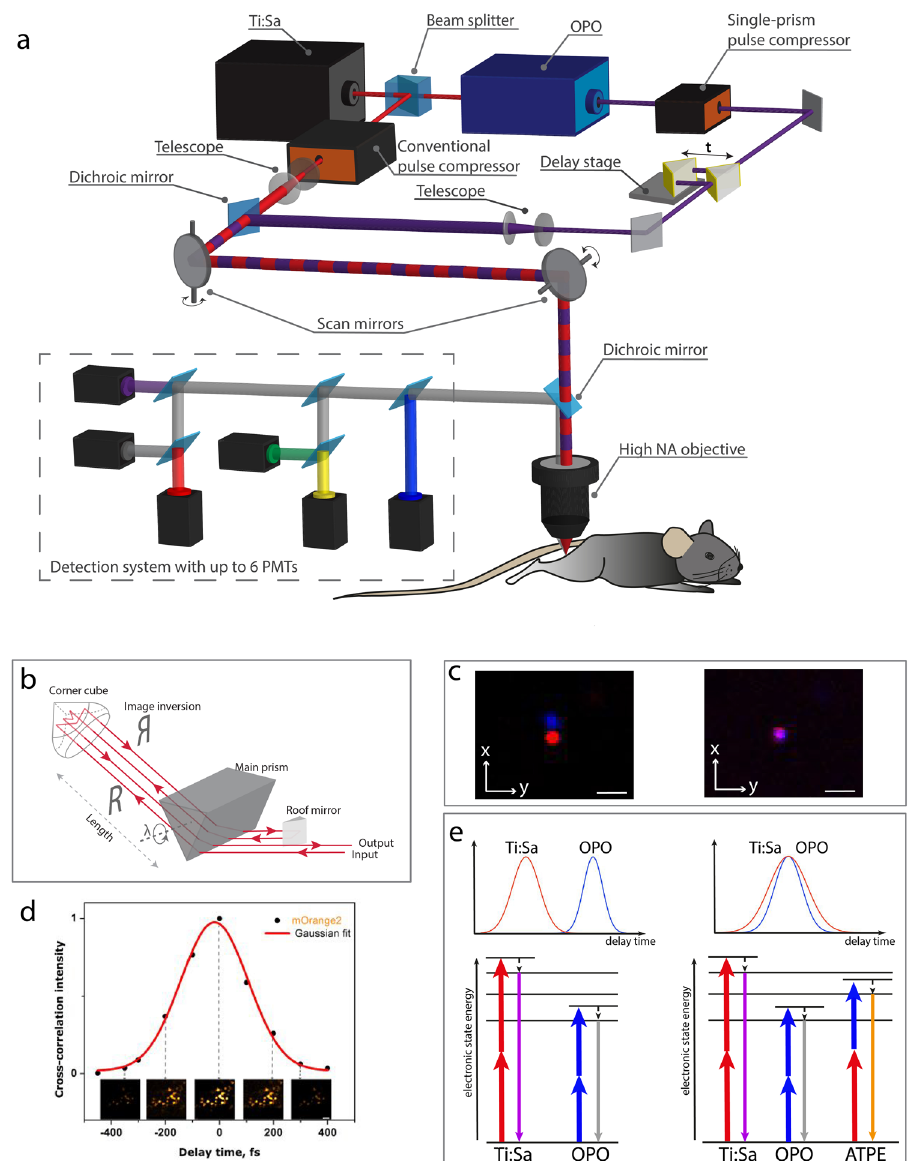
Figure 1. Principle of wavelength mixing two-photon microscopy: setup and characterization. ( a ) Imaging setup. A femtosecond laser (Ti:Sa) beam is divided in two fractions by a beam splitter. One is adjusted in a microscope, the second pumps an OPO. Pulses from Ti:Sa and OPO are synchronized using a delay stage (t) and spatially coaligned. GVD compensation is achieved using a conventional prism-based and a single-prism pulse compressors for Ti:Sa and OPO, respectively. The relative divergence of two laser beams is controlled using telescopes. Galvanoscan mirrors provide raster scanning the area up to 500 × 500 um 2 . Chromatic aberration between NIR and IR wavelength of two lasers is corrected by the high numerical aperture objective. The non-descanned detection system is equipped with six PMTs. ( b ) Single-prism pulse compressor. Negative dispersion is accumulated on the four-pass travel through the main prism. The distance between a corner cube and the main prism is half that of the conventional design due to the image inversion of the corner cube. Pulse compression at different wavelengths can be achieved by rotating only one prism. ( c ) Spatially separated (left) and overlapping (right) Ti:Sa (red) and OPO (blue) foci in the microscope, measured on a 100 nm fluorescent bead ( λ emission = 605 nm). Scale bars, 0.2 μ m. ( d ) Optimization of the ATPE. The mOrange2 fluorescent signal can be independently controlled by adjusting the delay between pulses. The insets represent images of HEK cells expressing mOrange2 at different delay times. Scale bar, 50 μ m. ( e ) Spatiotemporal overlapping of two laser pulses. Left side: unsynchronized pulses (850 nm and 1230 nm) provide dual two-photon excitation, i.e. two parallel symmetric two-photon excitation processes. Right side: The wavelength mixing appears only if the pulses are synchronized in time and the two foci are matched in space. A third, asymmetric two-photon excitation process additionally takes place, making further fluorophores visible. Hence, simultaneous triple two- photon excitation of a broad set of chromophores is